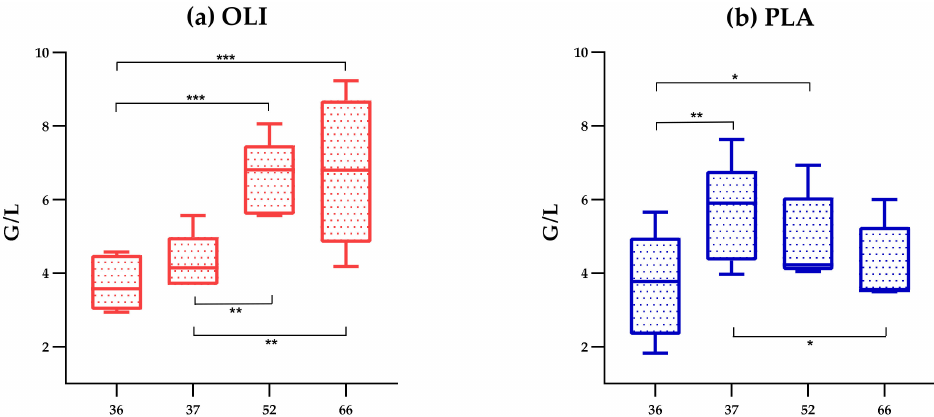
Figure 6. Changes in neutrophilic granulocytes per group (( a ), OLI, n = 6; ( b ), PLA, n = 5) from day 36 to day 66 in the blood after vaccination. Cell counts were determined by flow cytometry on days 36 (during supplementation and before vaccination), 37 (during supplementation and after vaccination), 56, and 70 (after supplementation). One-way analysis of variance for repeated measurements (assumed normal distribution). * ( p < 0.05), ** ( p < 0.02), *** ( p < 0.01). There is no significance between the two groups at any time point